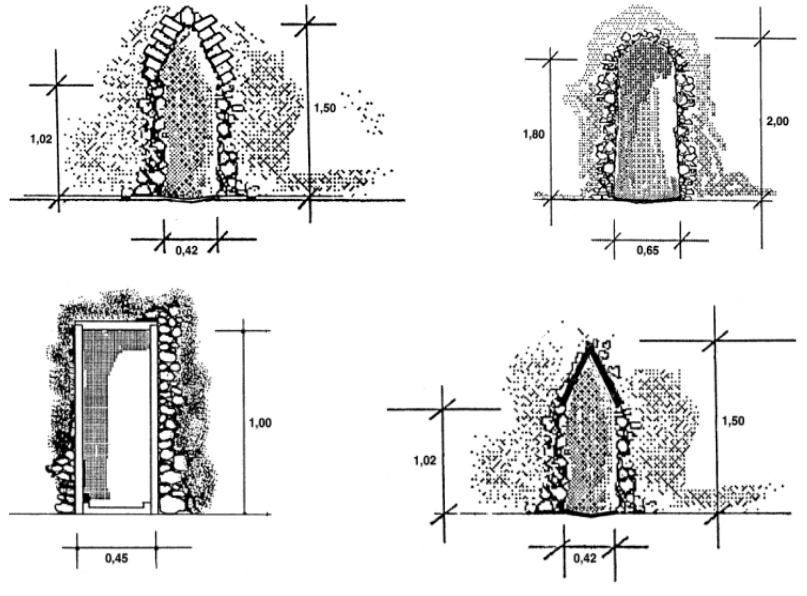
Figure 7. Sections of the “ Fontana della Rua ” tunnel in Todi, Umbria region